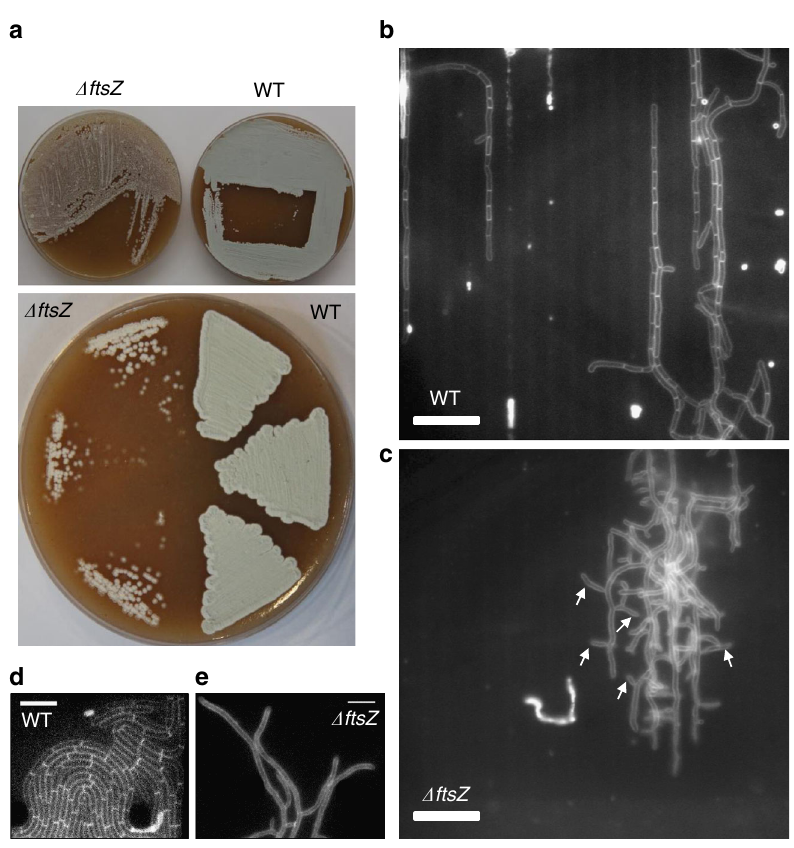
Fig. 1 Comparison of growth and cross-wall formation in wild-type and Δ ftsZ cells. a growth and re-streaking of Δ ftsZ and wild-type cells on TBO agar plates. Top panel shows growth of the strains from freezer stocks. Bottom panel shows cell regrowth in both mutant and wild-type from three independent colonies following growth at 30 °C for 3 days. b , c representative images of wild-type ( b ) and Δ ftsZ mutant ( c ) cells growth in our home-made micro fl uidic device in the presence of GYM media. Cell membranes were stained with FM4-64 dye. Note the presence of cross-walls in wild-type cells. White arrows indicate cell branching in the Δ ftsZ mutant. Scale bar = 10 µ m. d , e representative image of wild-type ( d ) and Δ ftsZ mutant ( e ) cells growth in GYM media in the CellASIC ONIX micro fl uidic chamber. Cell wall was labelled with 50 µ M NADA. Scale bar = 5 µ